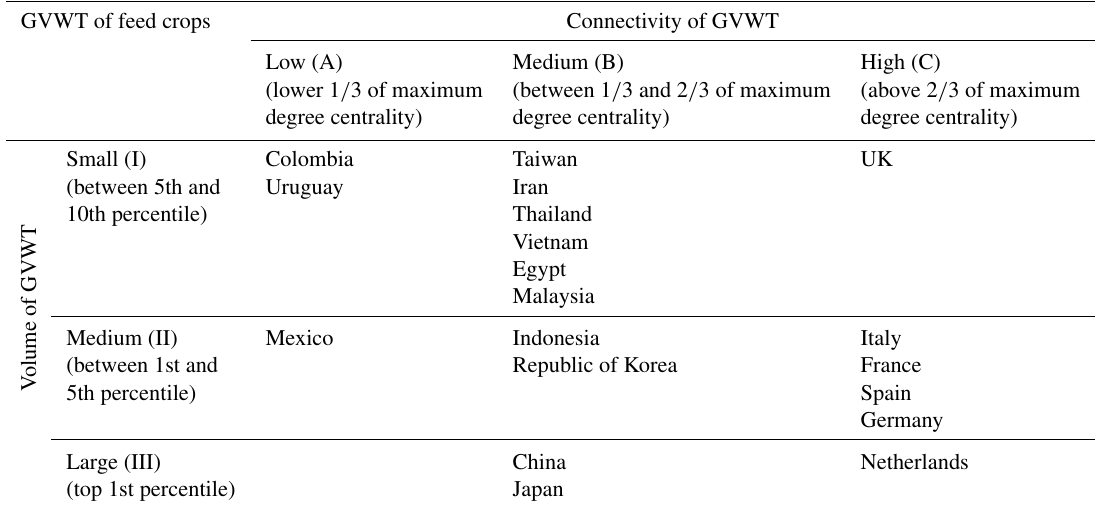
Table 3. Classification of importers by connectivity and volume of GVWT for feed crops (maize and soybean). GVWT of feed